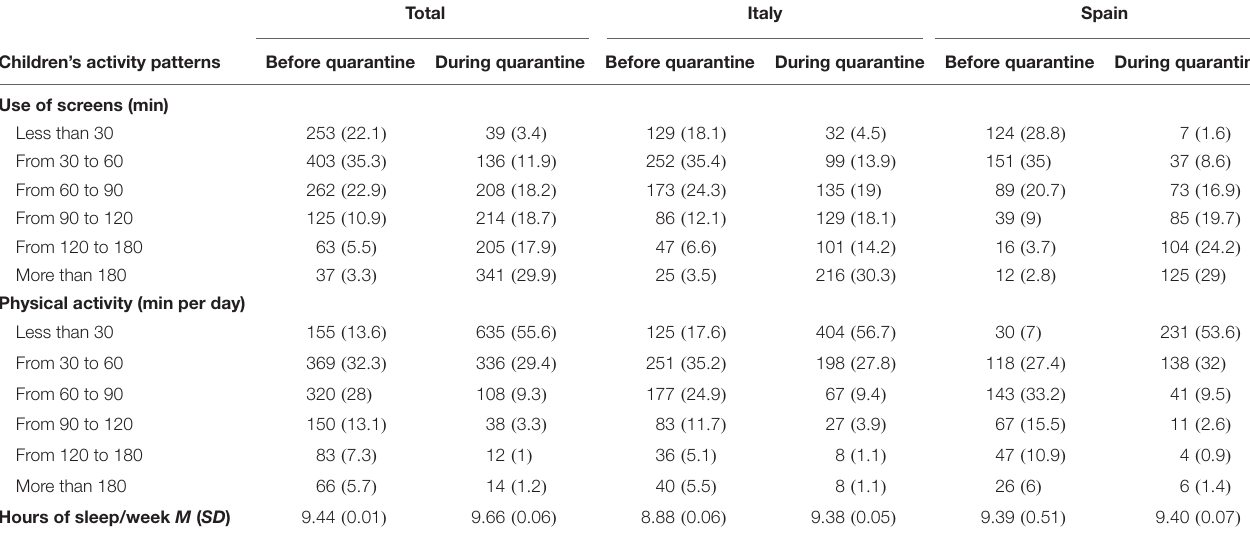
TABLE 4 | Children’s patterns of use of screens, daily physical activity, and hours of sleep before and during the quarantine. Total Italy